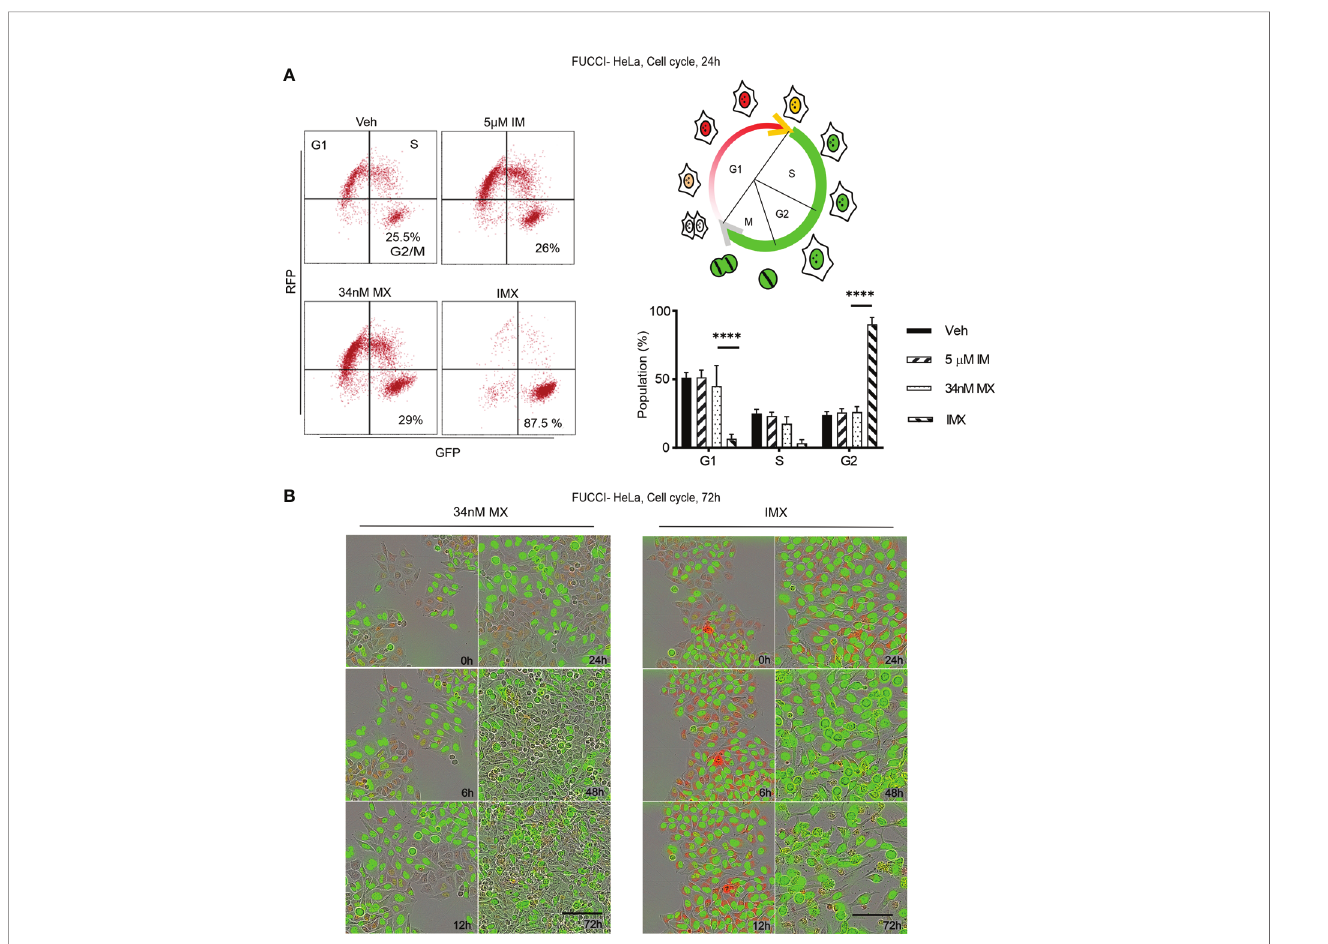
FIGURE 5 | c-Abl inhibition in combination with MX causes complete G2 arrest in FUCCI-HeLa cells. (A) Flow cytometry data on FUCCI-HeLa cells in different cell cycle phases. The representative dot plots show cell cycle after different treatments where lower right quadrant shows G2/M population. The picture demonstrates cell cycle in terms of FUCCI system where newly divided daughter cells have no color, G1 cells show red fl uorescence, G1-S transition shows yellow fl uorescence, and S/G2/M shows green fl uorescence. G2/M population was separated from S in FACS analysis. Bar chart shows percent of population in each phase (95% CI of difference for G0/G1 phase: MX vs . IMX is 21.88 – 55.45 where p < 0.0001; G2/M phase: MX vs . IMX is -82.89 to -45.35 where p < 0.0001, 2 way ANOVA). (B) Representative images of FUCCI-HeLa cells in 5 time points after 34 nM MX or IMX treatments. Scale bar = 50 µm.